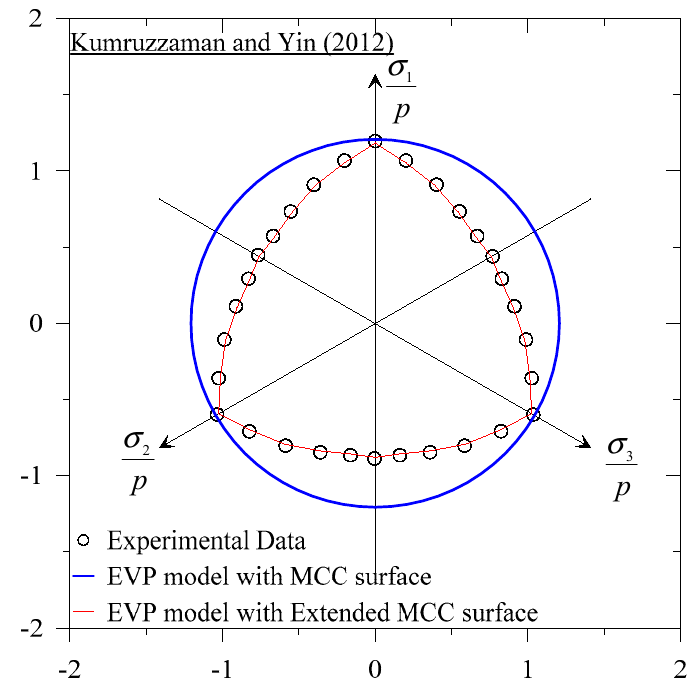
Figure 2. Comparison of the MCC surface and the extended surface in the 𝜋 -plane.